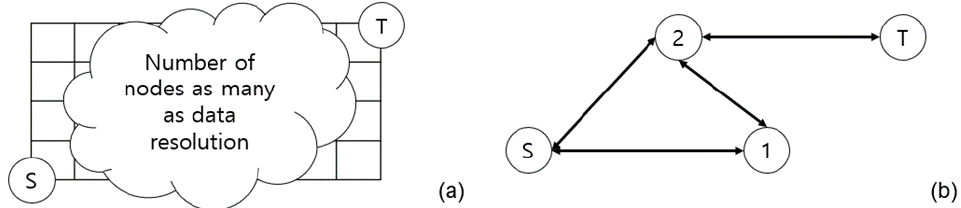
Figure 3. Difference between the pathfinding process with and without a topology map when using an image-based map. ( a ) A significant number of nodes must be handled, because each pixel in the image is used as a node. ( b ) Pathfinding can be performed much more easily with a topology map, as the number of nodes to be processed is significantly reduced.